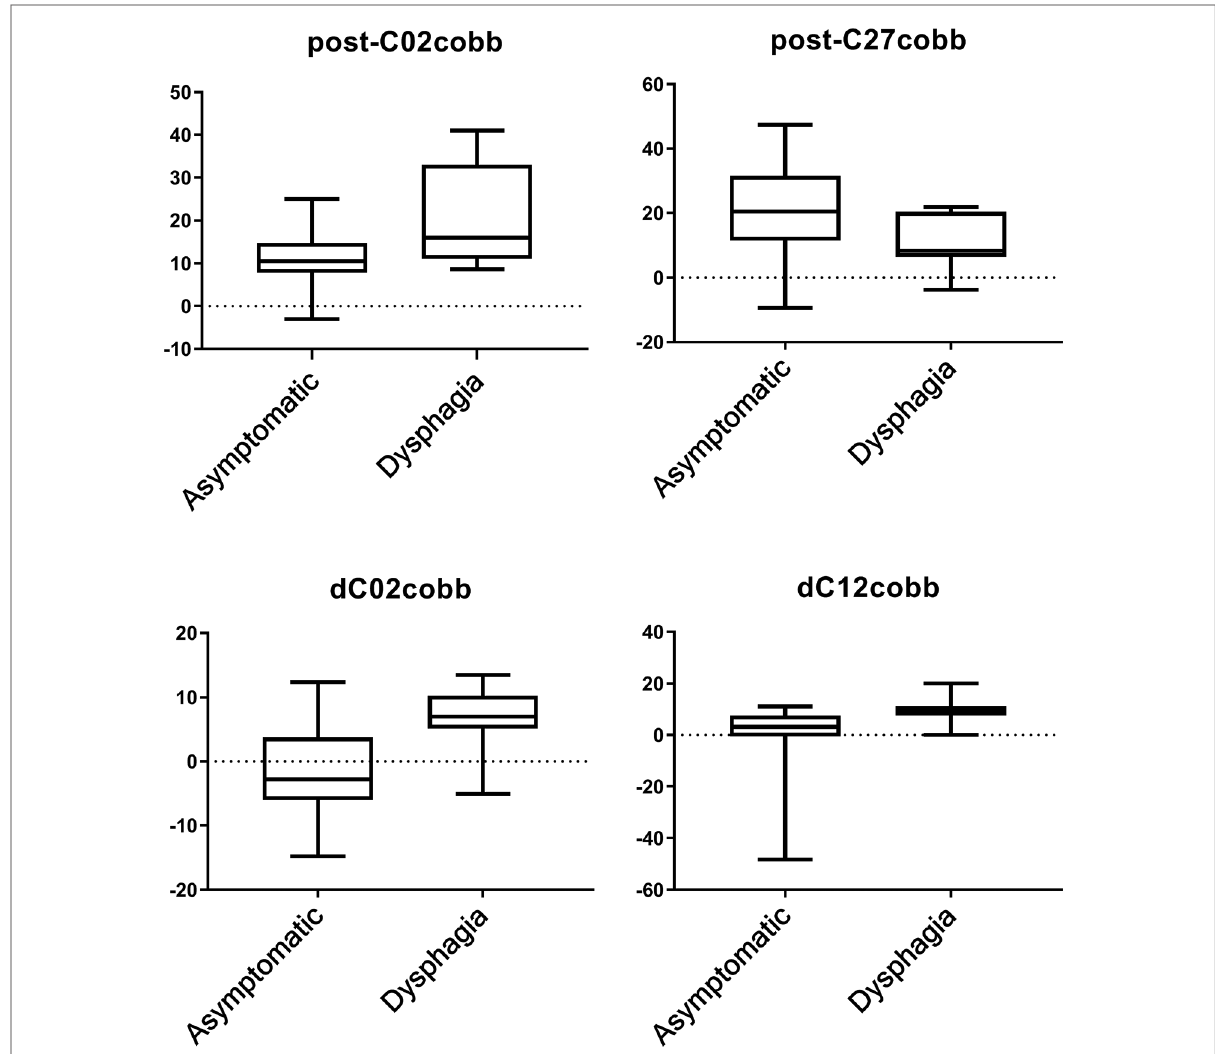
FIGURE 2 Comparison of cervical alignment between dysphagia and asymptomatic groups.